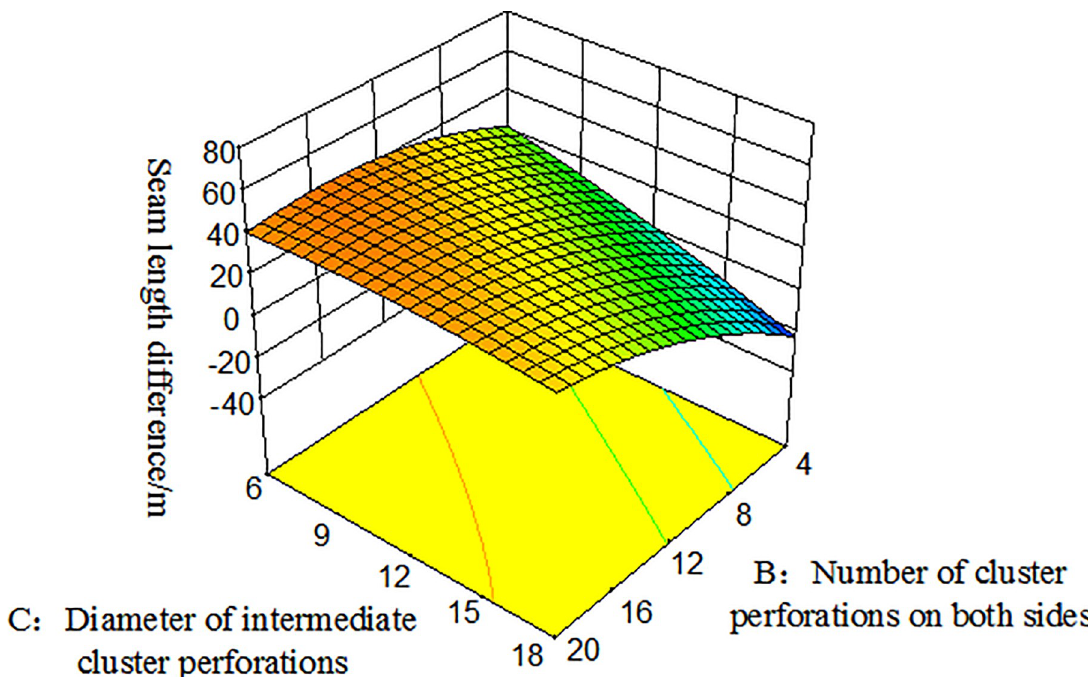
Fig 15. Three-dimensional response surface diagram of the number of cluster perforations on both sides and the diameter of the middle cluster perforation hole on the seam length difference.